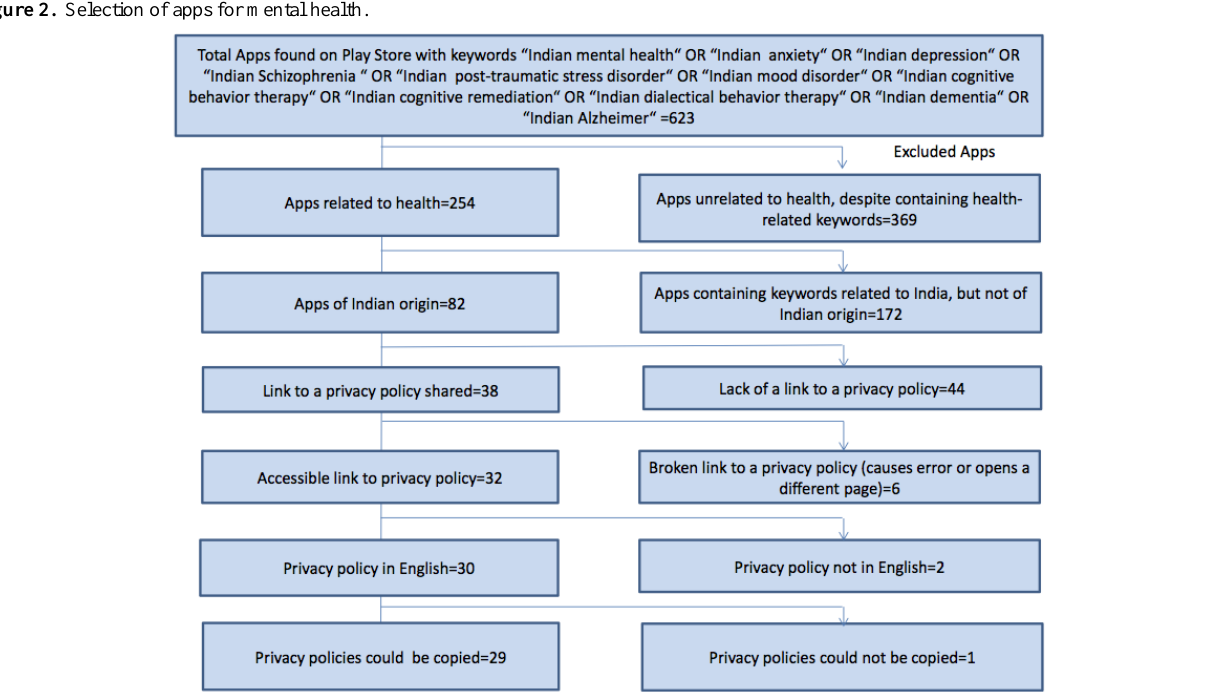
Figure 2. Selection of apps for mental